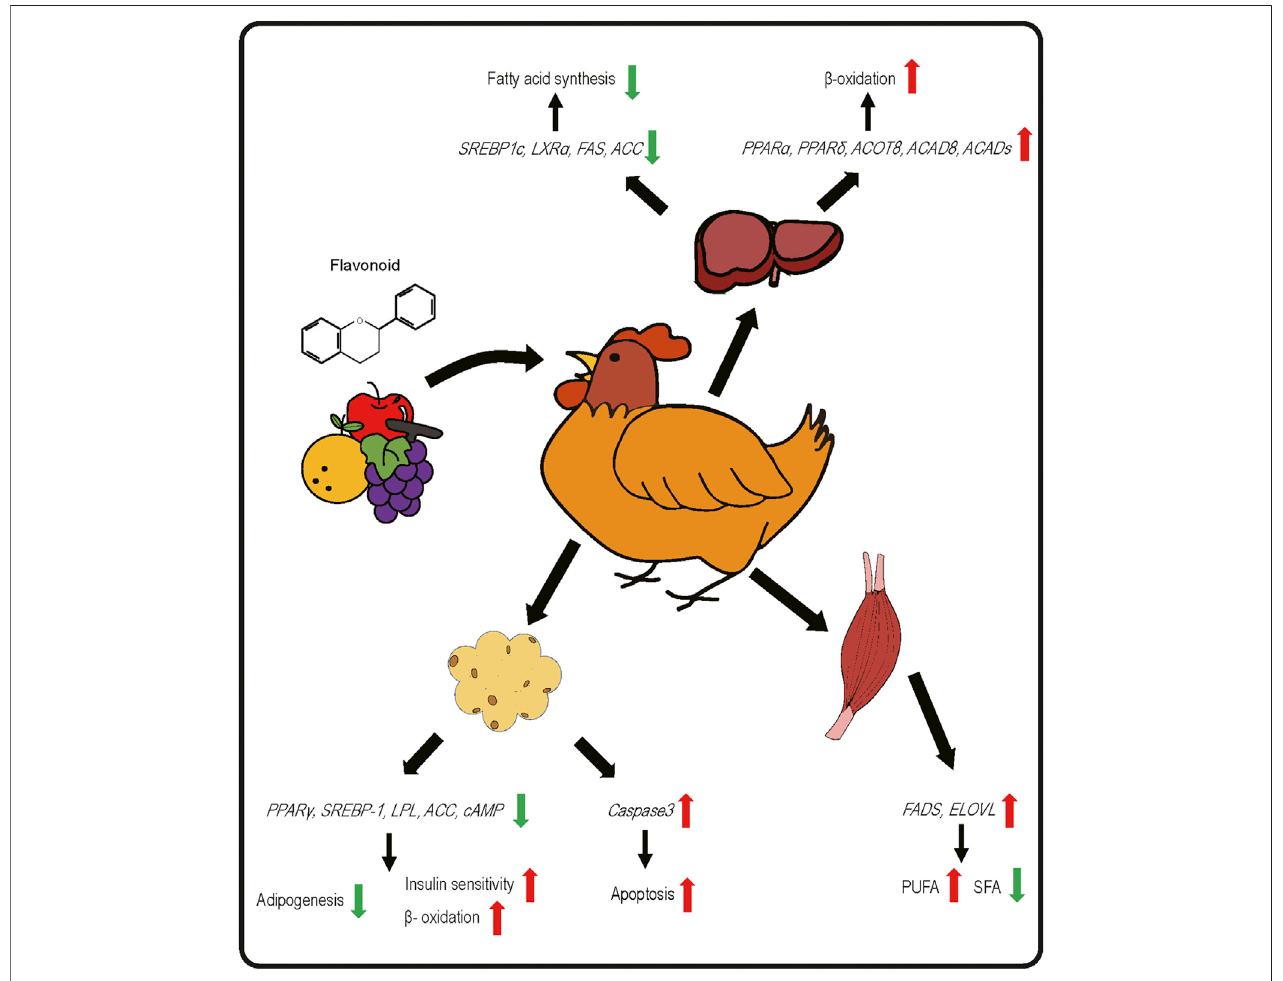
FIGURE 2 | Effects of dietary fl avonoids on gene expression related to lipid metabolic pathways in liver, skeletal muscle, and adipose tissue of poultry species.